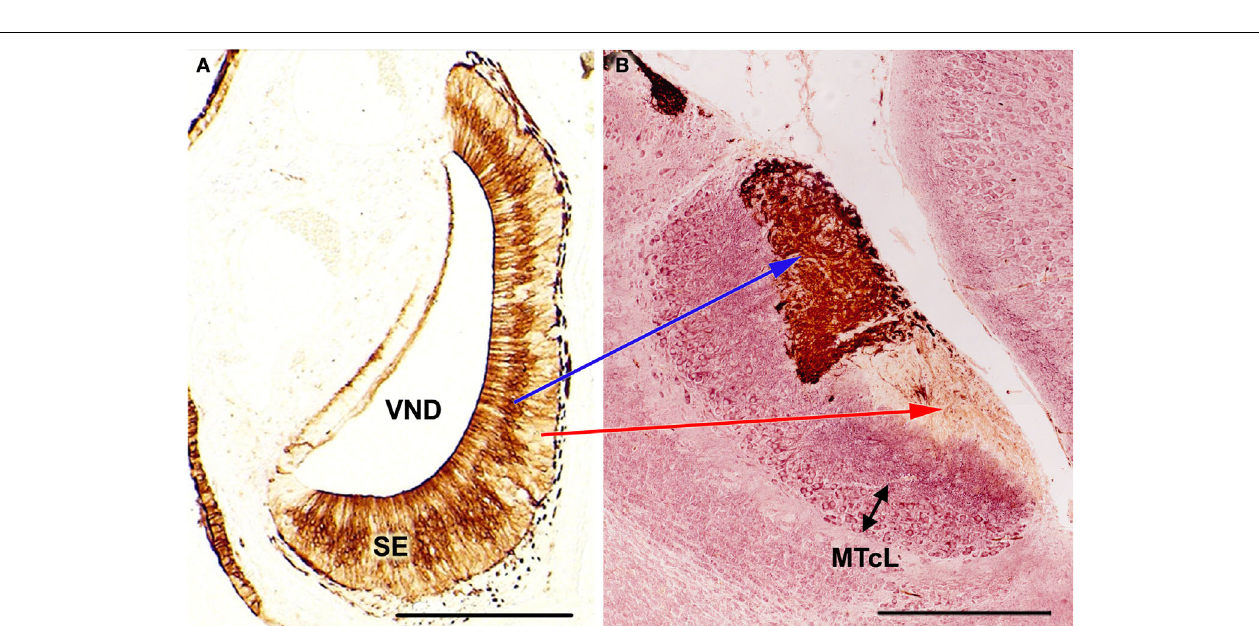
FIGURE 3 | Immunolabeling demonstration of the zonal organisation in the vomeronasal system of mice, showing the correlation apical/SE-anterior AOB, basal/SE-posterior AOB. (A) (After Salazar and Sánchez Quinteiro, 2003): Transverse section of the vomeronasal organ stained by the lectin LEA showing the differentiation between the basal and apical layers of the SE. (B) (After